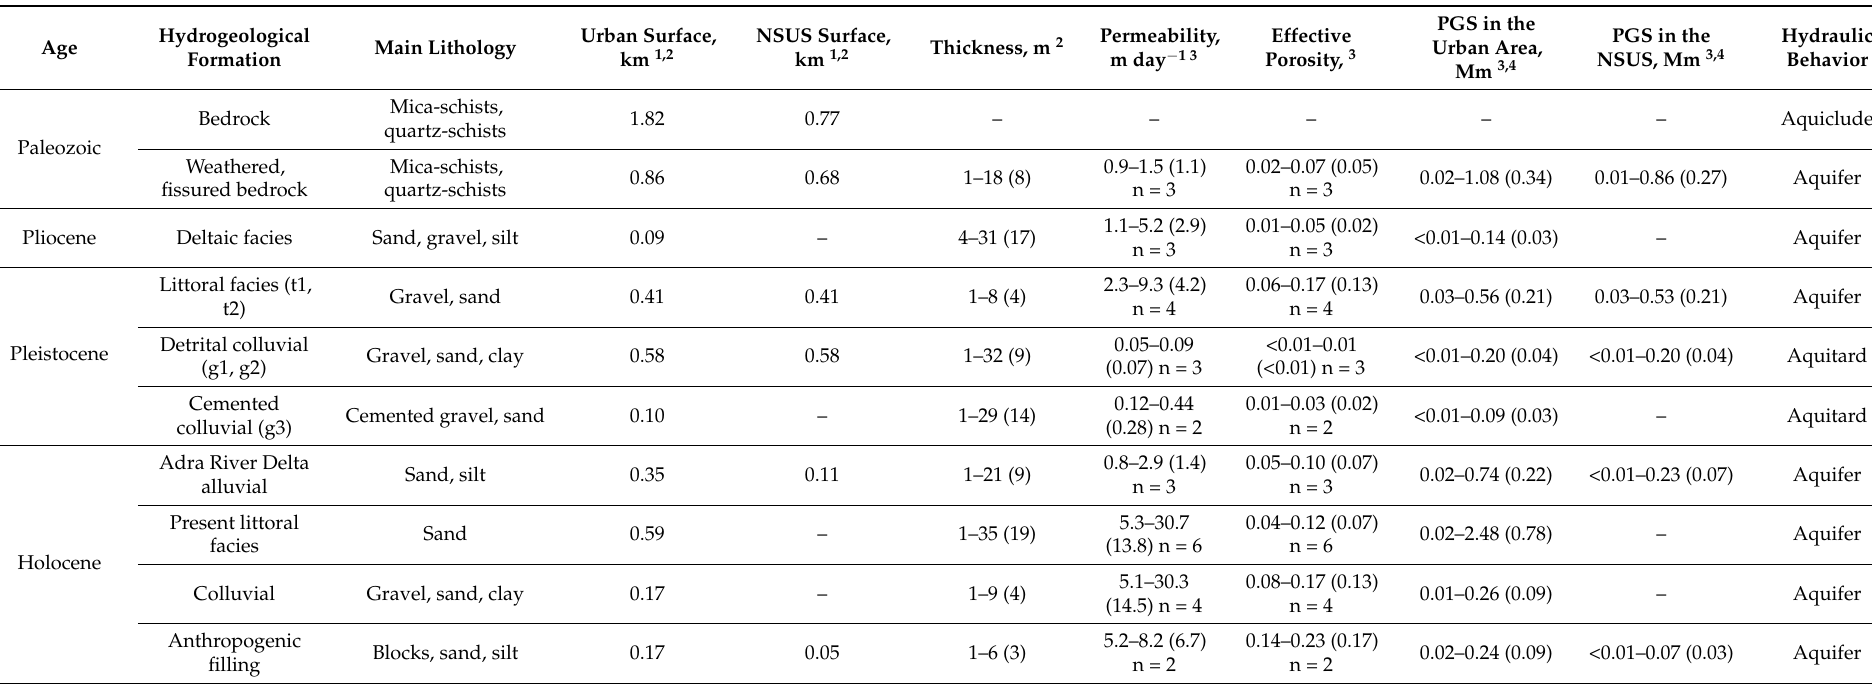
Table 2. Geometry, hydraulics data, and potential groundwater storage (PGS) of the hydrogeological formations in the total urban area and the